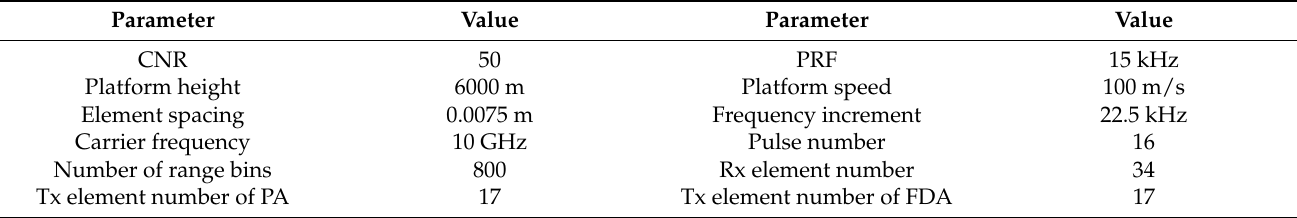
Table 1. Radar parameters for the simulated